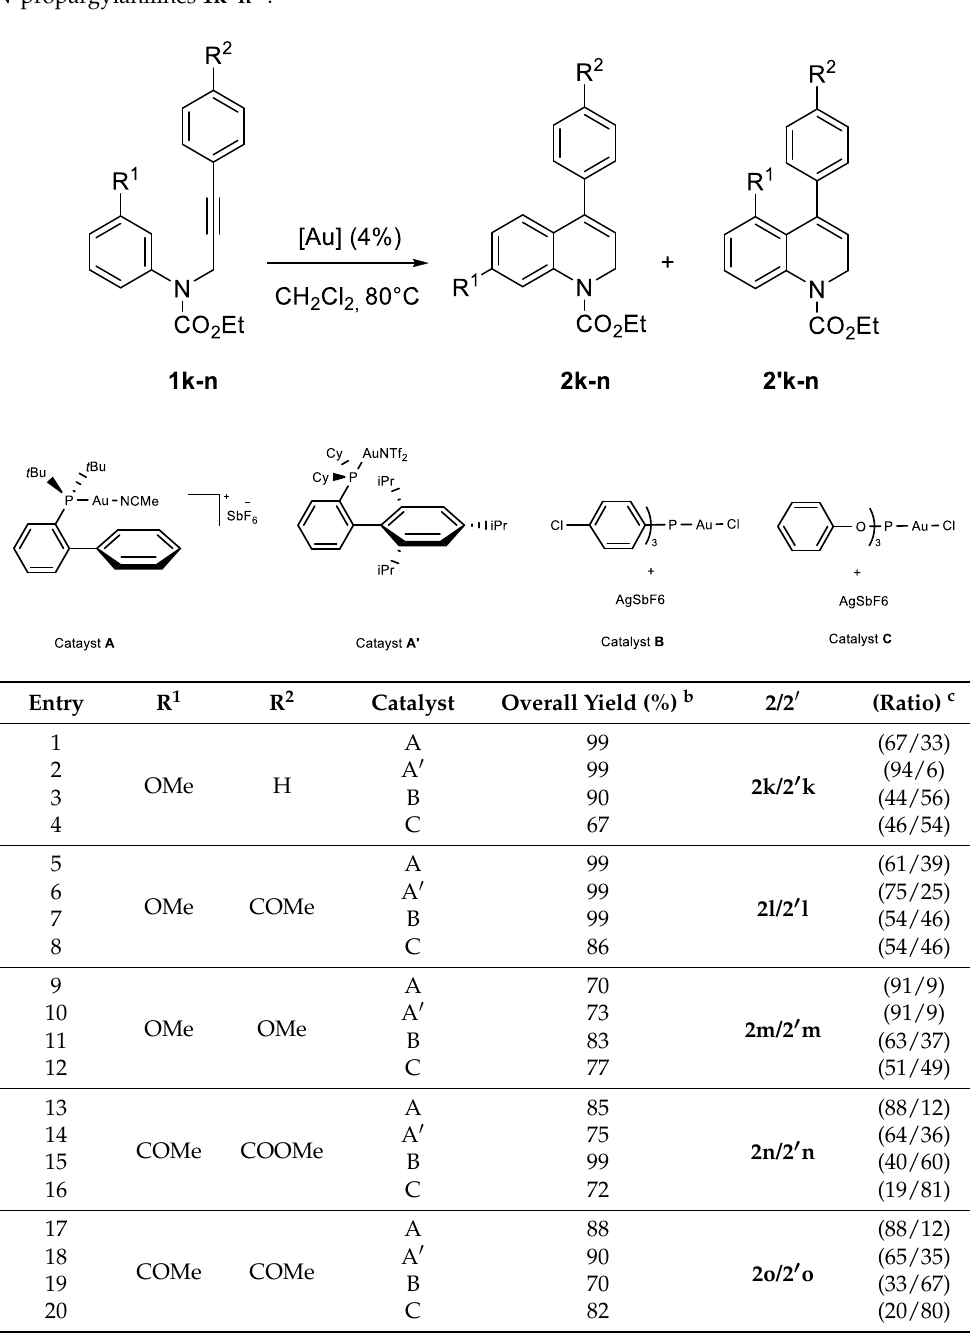
Table 3. Ortho - vs. para -position annulation in the gold(I)-catalyzed IMHA of the N -ethoxycarbonyl- N -propargylanilines 1k – n a .